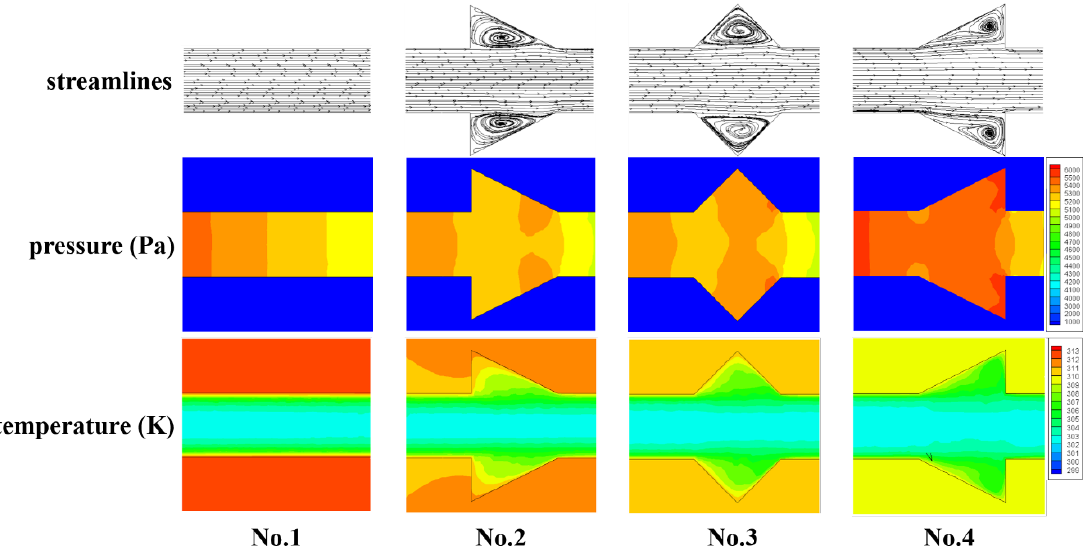
Figure 9. Local streamlines, pressure and temperature distribution of Group 1 and straight microchannel (No. 1).